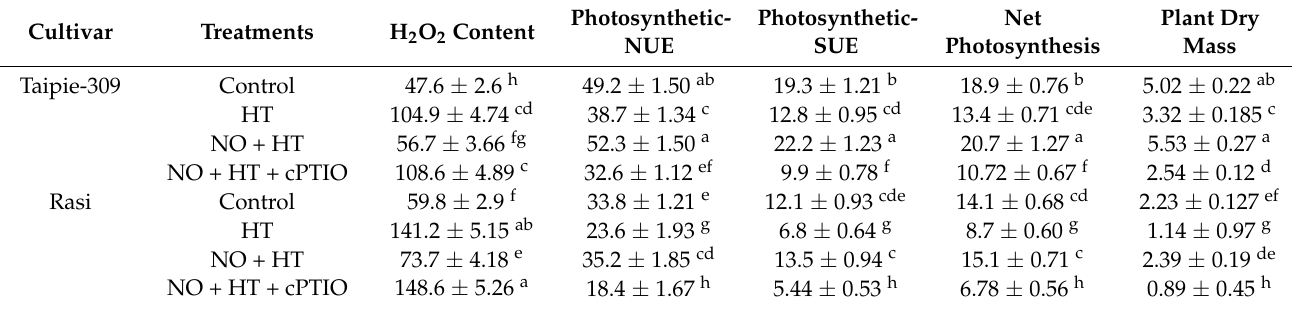
Table 5. H 2 O 2 content (nmol g − 1 FW), plant dry mass (g plant − 1 ), net photosynthesis ( µ mol CO 2 m − 2 s − 1 ), photosynthetic NUE (g m − 2 ) and photosynthetic-SUE (g m − 2 ) in Taipie-309 and Rasi cultivars of rice ( Oryza sativa L.) plants grown with/without high temperature (HT) stress and treated with foliar 100 µ M SNP (NO donor) and 100 µ M cPTIO at 30 days after germination